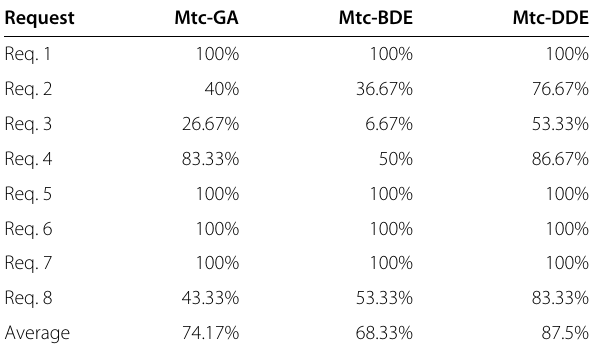
Table 11 Hit percentages of the hybrid methods for 200 CPs with arbitrary price